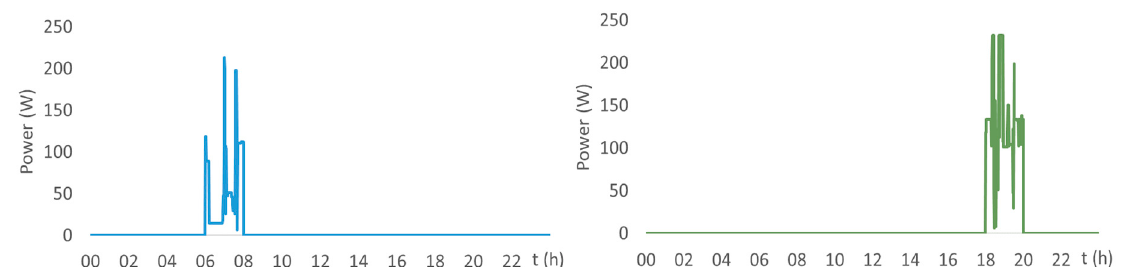
Figure 8. Flexibility Forecast Diagram for REDD dataset for the building 1 morning period from 06:00 to 08:00 ( left ), and the afternoon period from 18:00 to 20:00 ( right ).